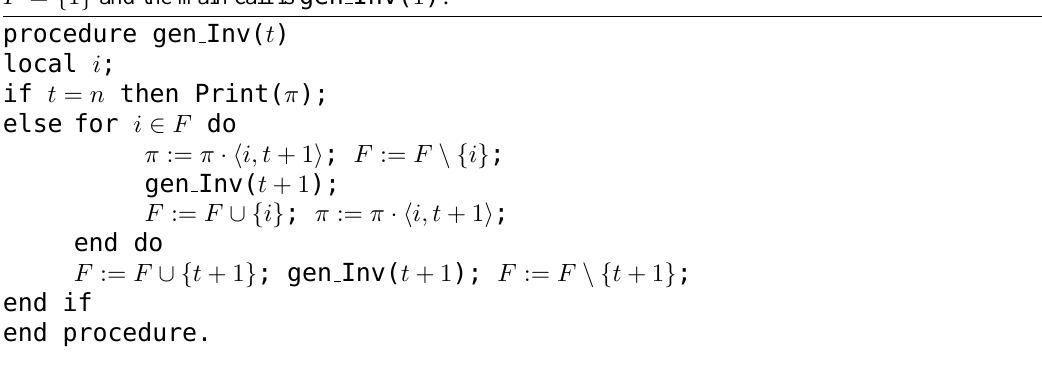
Algorithm 3 Procedure generating length- n involutions by fixed points. Initially π is 1 2 3 . . . n ∈ S n , F = { 1 } and the main call is gen Inv( 1 )